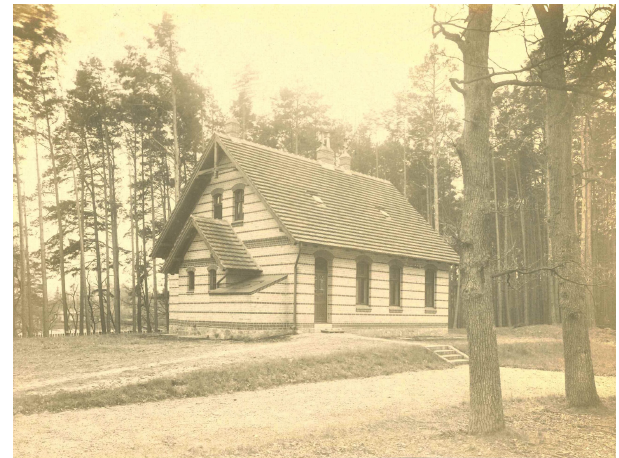
Figure 4. Ground plan of the Seddin Observatory building. Source: Schmidt